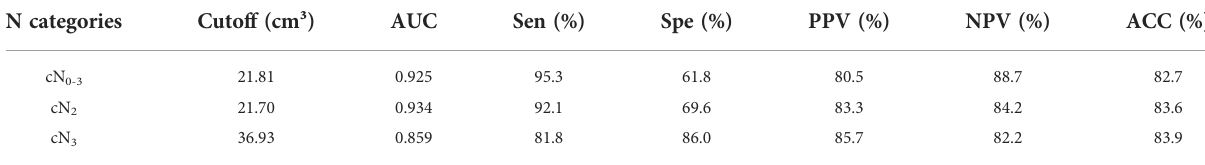
TABLE 3 Receiver operating characteristic analysis of N-stage based gross tumor volume for identifying resectability of gastric adenocarcinoma in the training cohort. N